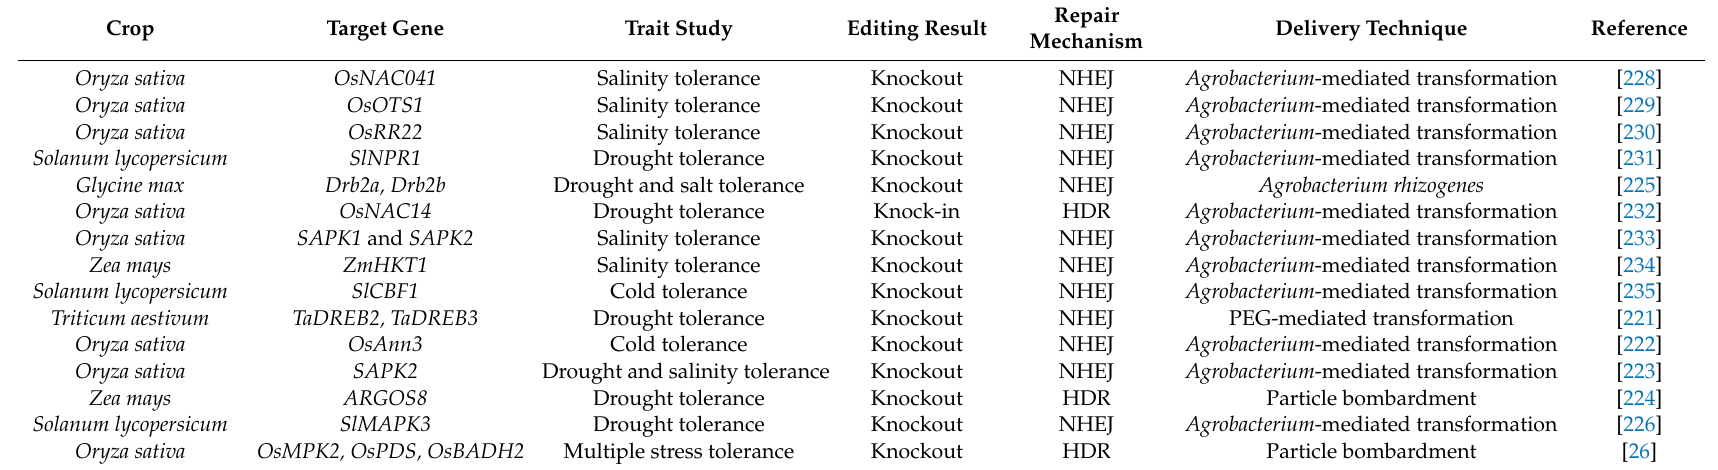
Table 4. Summary of CRISPR / Cas9 applications in major crops for abiotic stress